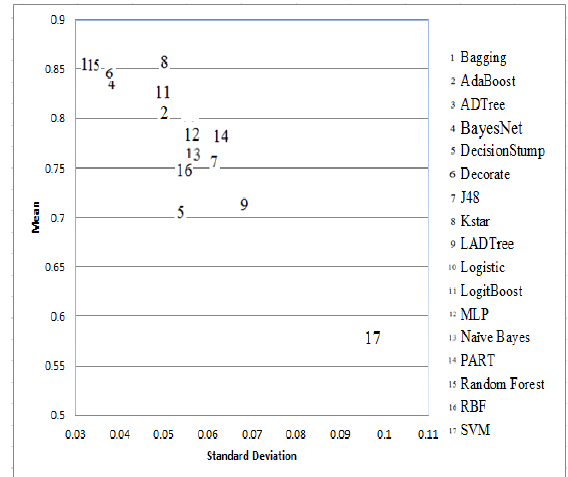
Figure 11. AUC mean value with scenarios 2 and 4 and deviation from mean for classification of all